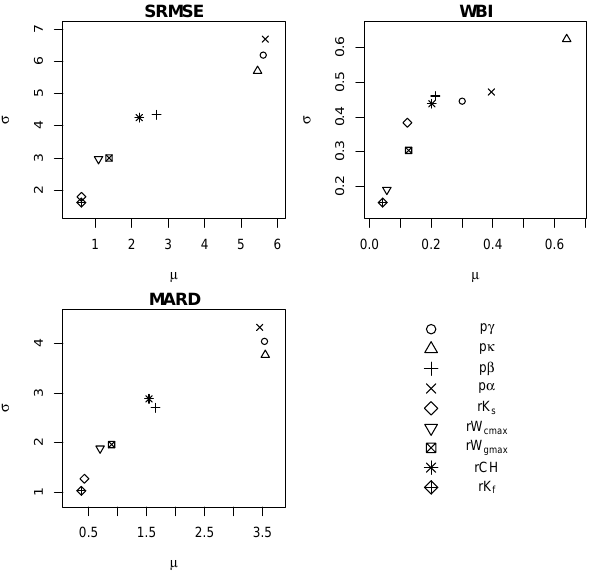
Figure 3. Multiobjective sensitivity analysis result based on the Morris method ( µ is the sensitivity measure, and σ demonstrates the degree of nonlinearity or factor